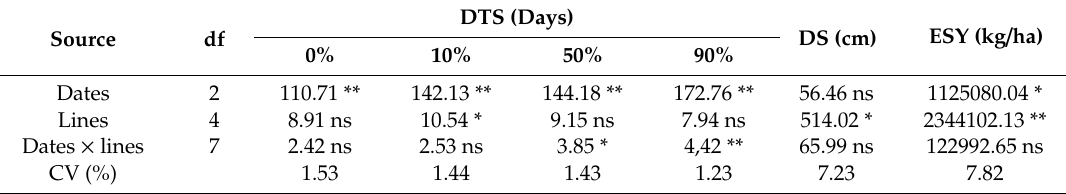
Table 4. Mean squares of the combined analysis of variance (ANOVA) of Experiment